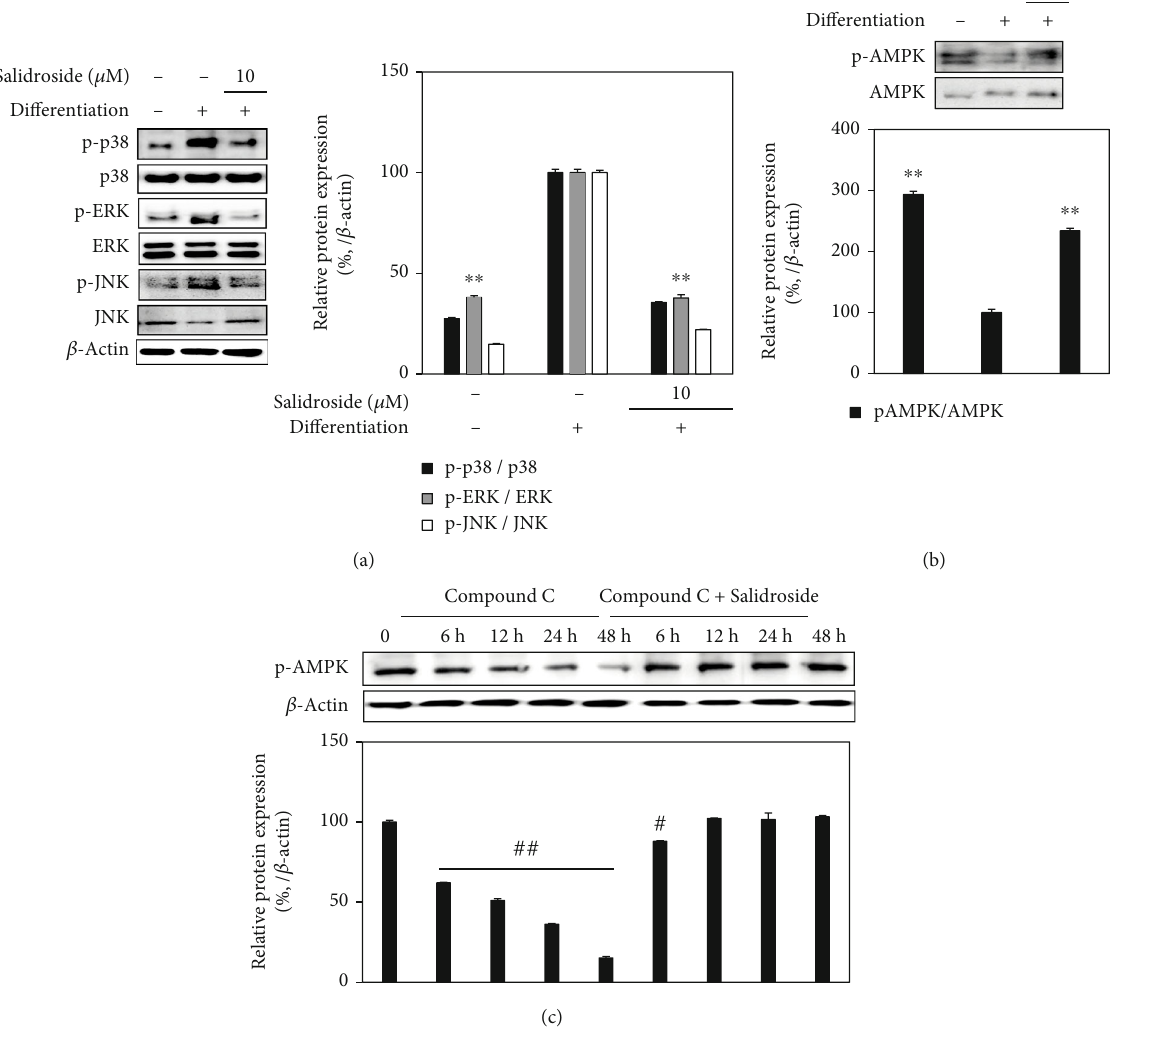
Figure 10: E ff ect of salidroside (10 μ M) on the levels of (a) p38, ERK, and JNK MAPKs and (b) AMPK. Phosphorylated (p-) and total protein levels analyzed by Western blotting using adipo-induced hBM-MSC lysates at day 14 of di ff erentiation. (c) Time-dependent p-AMPK levels were obtained at the designated times from adipo-induced compound C-treated hBM-MSCs lysates with or without salidroside (10 μ M). Compound C was used as an inhibitor of AMPK phosphorylation. Western blot bands were densitometrically quanti fi ed and plotted as relative percentage of the untreated di ff erentiated control group. Phosphorylation levels were measured via normalization of the phosphorylated (p-) protein against their total protein levels. β -Actin was used as internal loading control. ∗ p < 0 : 05 and ∗∗ p < 0 : 01 vs. the untreated di ff erentiated control group; # p < 0 : 05 and ## p < 0 : 01 vs. the di ff erentiated control group without compound C and salidroside